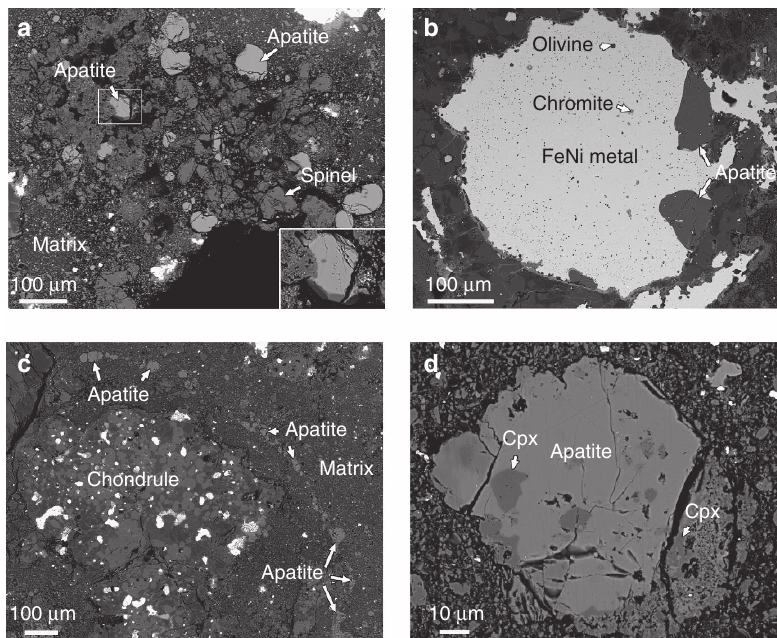
Figure 1 | Textural occurrences of apatite in DaG 978. ( a ) Backscattered electron image of apatite grains that are closely associated with a Ca,Al-rich inclusion. The apatite grain size varies from B 10 to 100 m m. Fine-grained anorthite has been partially altered to nepheline. The outline region contains a subhedral apatite grain with a well-developed crystal form. ( b ) Backscattered electron image of two apatite grains occurring at the margin of a large FeNi metal in a chondrule. The FeNi metal also contains fine-grained inclusions of chromite and olivine. ( c ) Backscattered electron image of apatite grains that resemble a chain of beads in matrix. ( d ) Backscattered electron image of a large apatite grain that is closely associated with high-Ca pyroxene (cpx). The high-Ca pyroxene grains are anhedral to euhedral and vary from 3 to 15 m m in